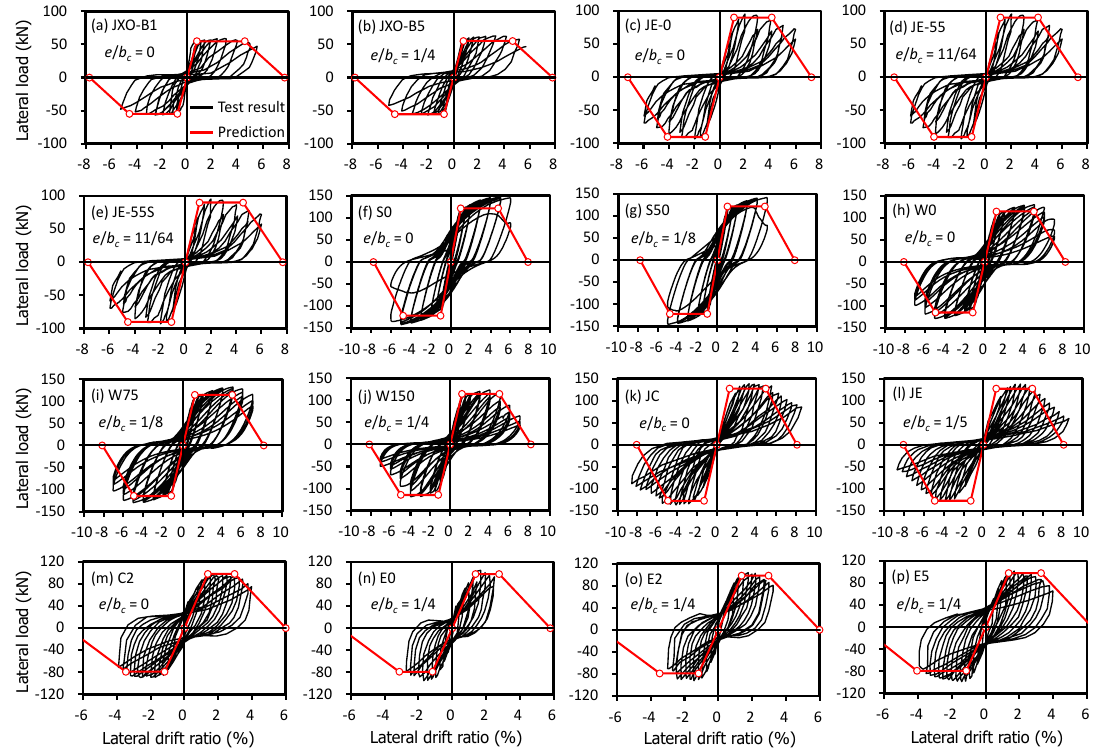
Figure 9. Comparison between test results and predictions with Eurocode 8. More specifically, the deformation capacity δ u by the predictions were quantita- tively compared with the test results δ T in Table 4: the deformation capacity δ T of the test